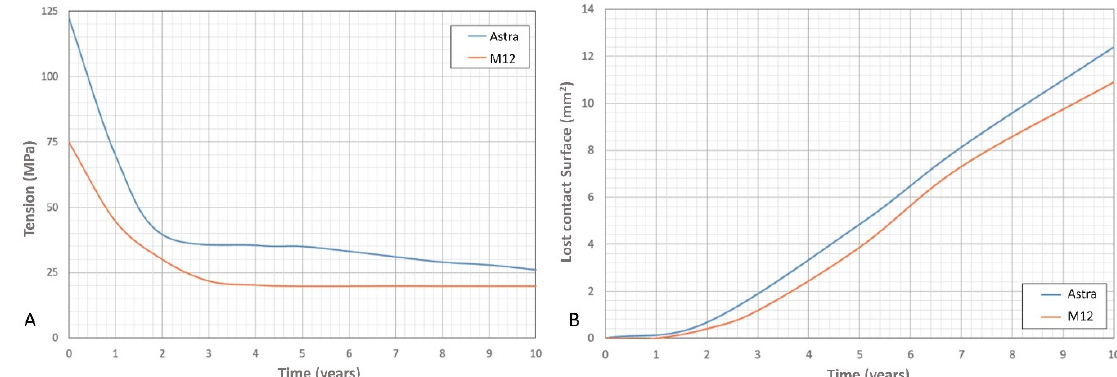
Figure 3. Progress of the stress state for the M-12 implant ( A ). Progress of the stress state for the Astra implant ( B ). Because of the bone loss, peak stress in the interaction between bone and implant is relaxed. Curves shown in Figure 3 represent the peak stress in the interaction between bone and implant, and it is not related to the same location along the time.